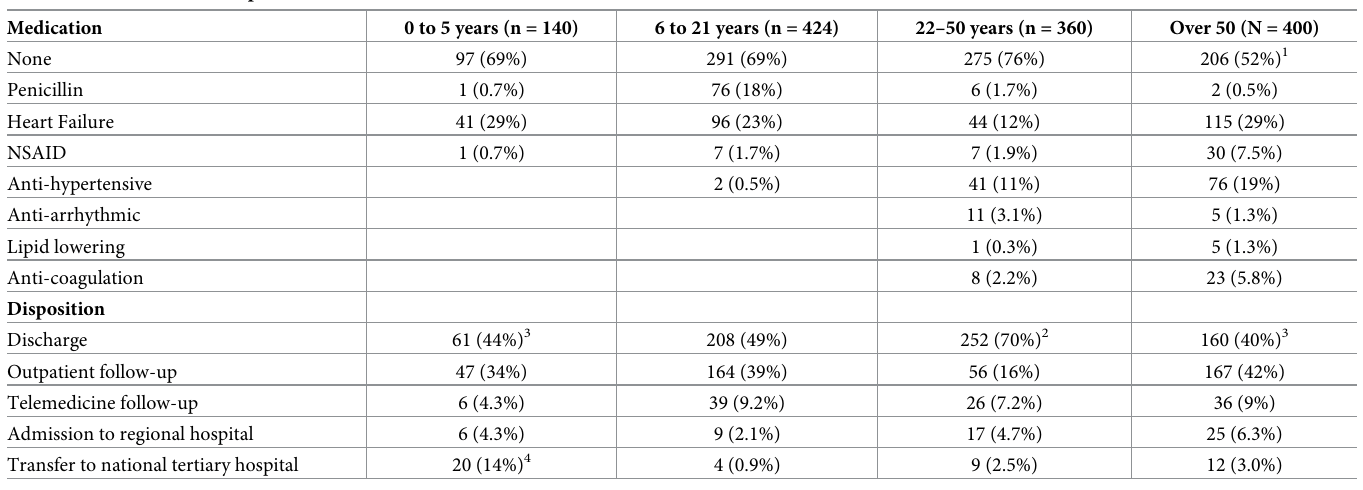
Table 2. Medications and